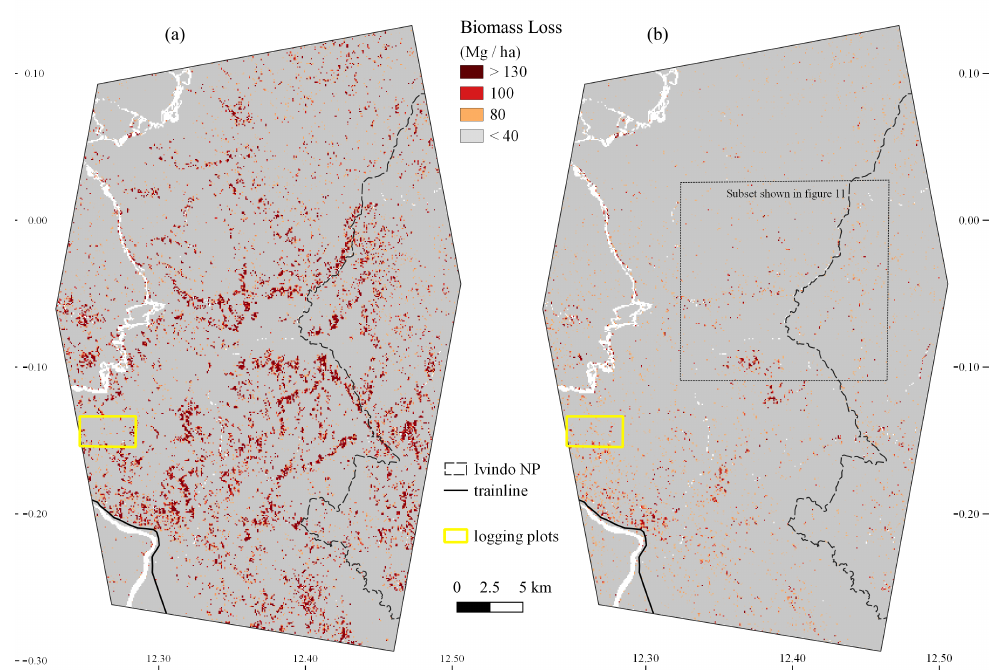
Figure 10. Maps of potential forest degradation based on TDX h φ change, ranging from grey (no detectable AGB loss) to dark red (>130 Mg AGB loss per ha). ( a ) Averaging changes across both pass directions led to a severe over-estimation of degradation. ( b ) Selecting pass at the pixel level mitigated topographic artifacts: the method we recommend